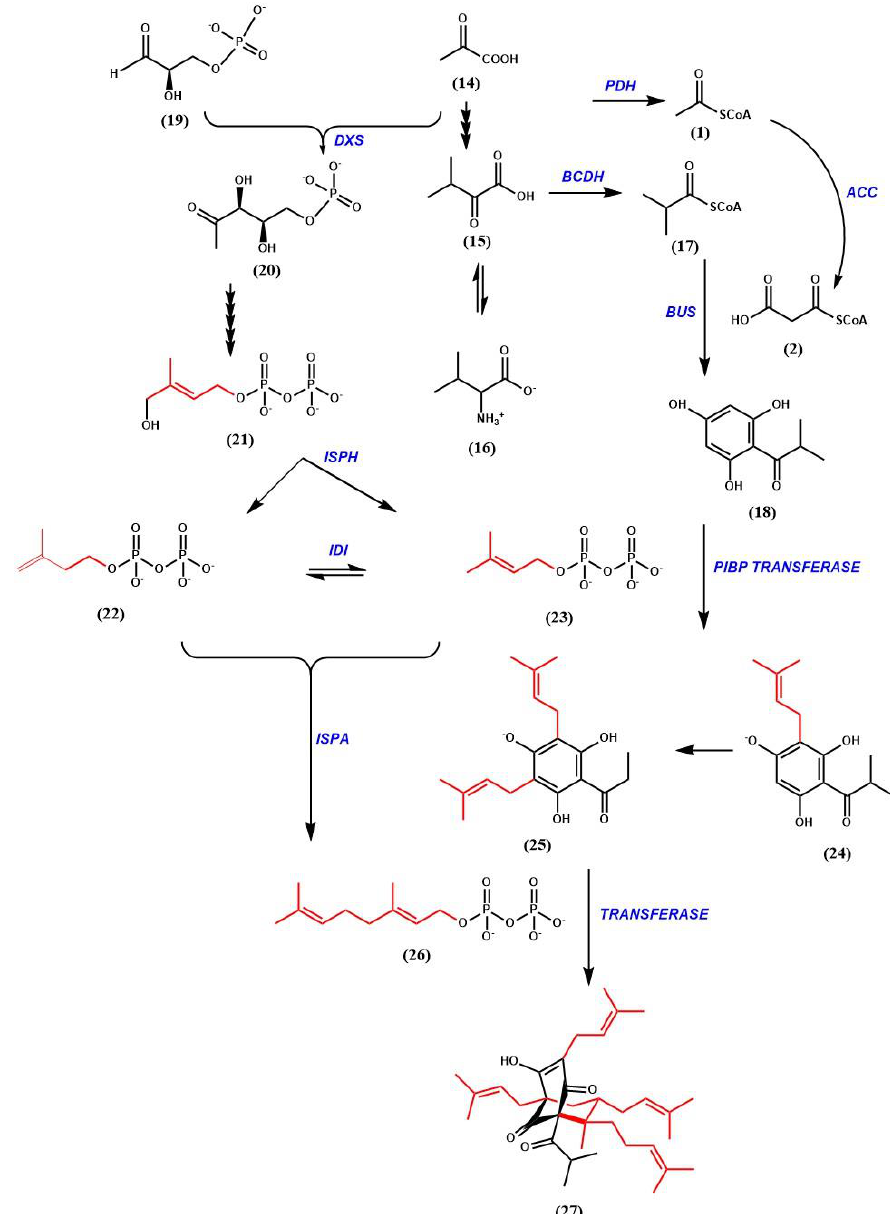
Figure 7. The hypothetical pathway for the biosynthesis of hyperforin: Prenylations are shown in red. Enzymes, represented in blue, are suggested by previous studies: PDH , pyruvate dehydrogenase; ACC , acetyl-CoA carboxylase; BCDH , branched chain α-keto acid dehydrogenase complex; PIBP transferase, phlorisobutyrophenone transferase; BUS , isobutyryl-CoA; DXS , 1-deoxy-D-xylulose-5-phosphate synthase; ISPH , 1-hydroxy-2-methyl-butenyl 4-diphosphate reductase; IDI , isopentenyl diphosphate isomerase; ISPA , Farnesyl pyrophosphate synthase.